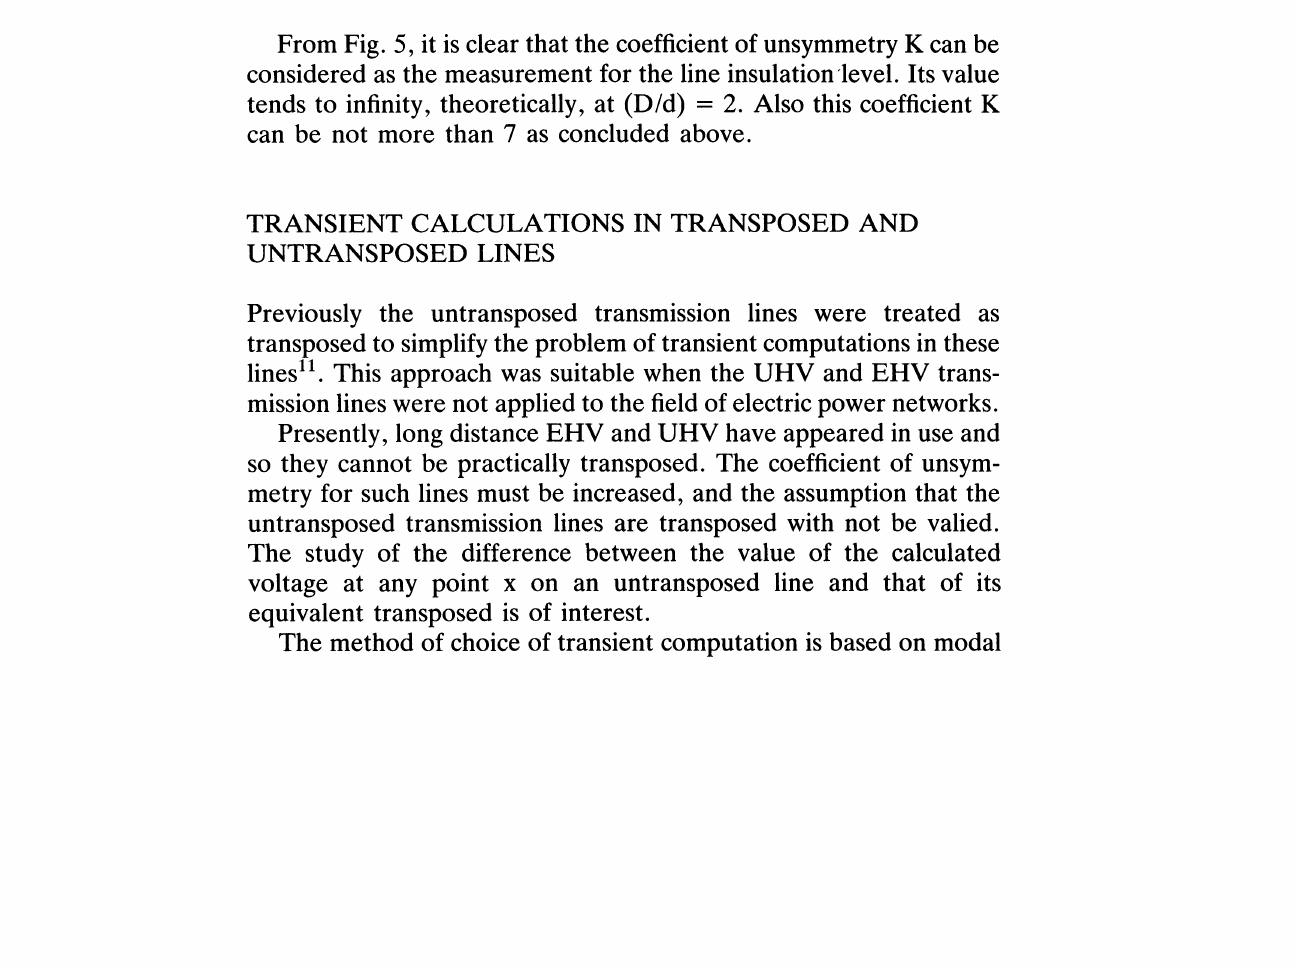
FIGURE 5 The coefficient of unsymmetry to distance ratio